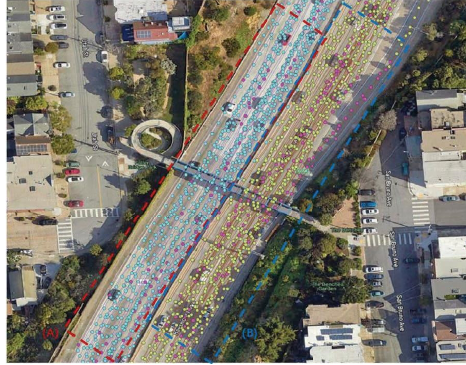
Figure 10: Extraction results of lane-changing trajectory points.